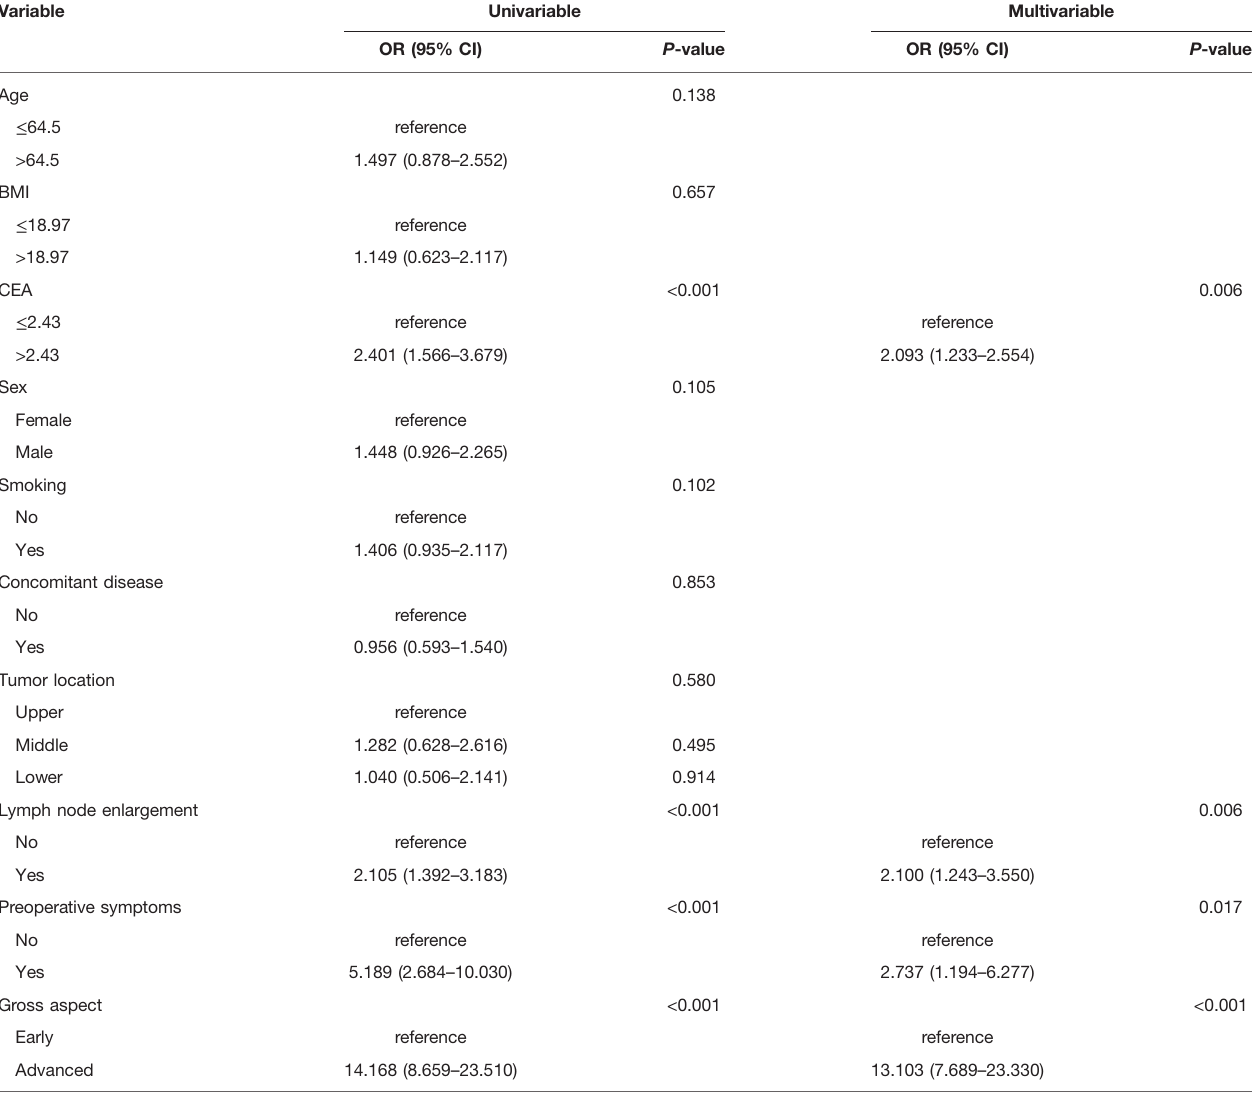
TABLE 4 | Logistic univariate and multivariate regression analysis of occult locally advanced ESCC based on preoperative data in the training cohort.